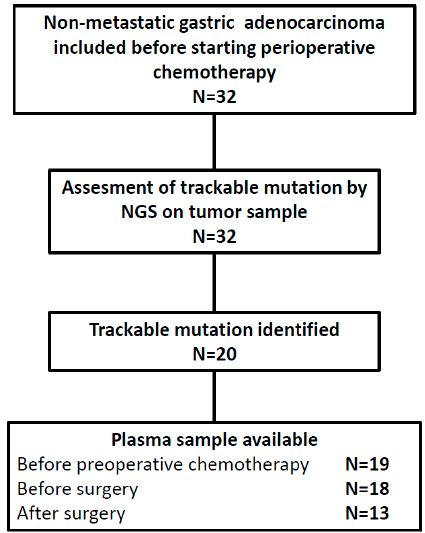
Figure 1. Study flowchart. NGS: next-generation sequencing.